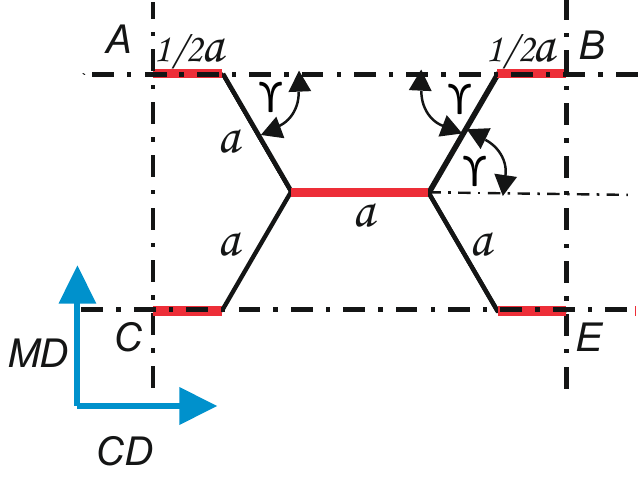
Figure 5. Dimensions of the periodic core cell.